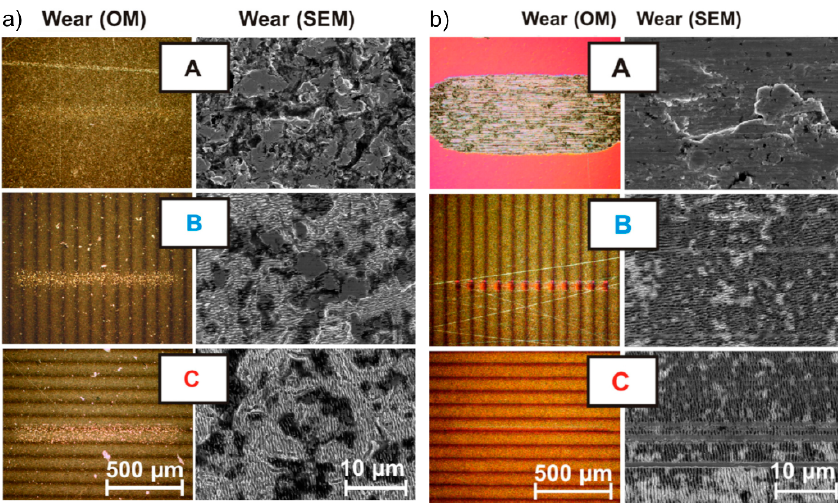
Figure 20. Optical micrographs (OM) and SEM micrographs (SEM) of the corresponding wear tracks taken after tribological analysis using engine oil: ( a ) X30CrMoN15-1; ( b ) pure titanium; ( A ) reference (no LIPSS); ( B ) perpendicular to ablation lines; ( C ) parallel to ablation lines. Reprinted from Bonse et al . [146], Copyright 2015, with permission from Elsevier.